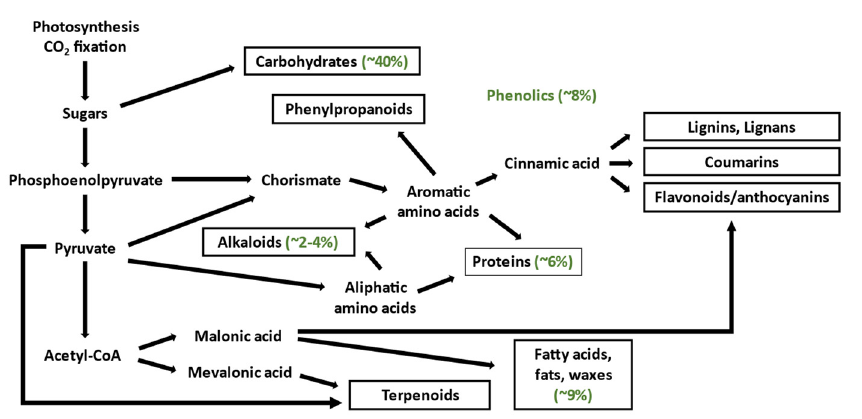
Figure 1. Tobacco biosynthetic pathways leading to primary and secondary metabolites. The green text shows the approximate dry weight composition of the most important compounds [5]. Desired classes of commercially viable compounds are indicated in black rectangles. This figure was assembled from several different scientific sources [5–8].